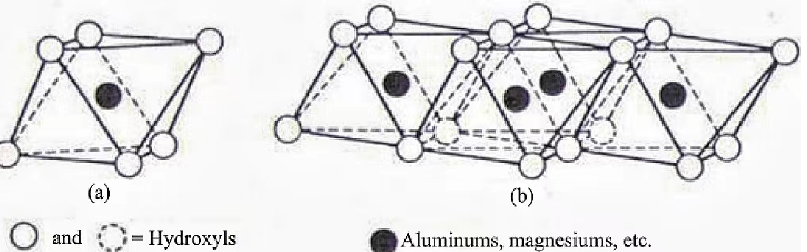
Figure 4. ( a ) Al location in octahedron; ( b ) alumina sheet. Reprinted with permission from Ref. [4].